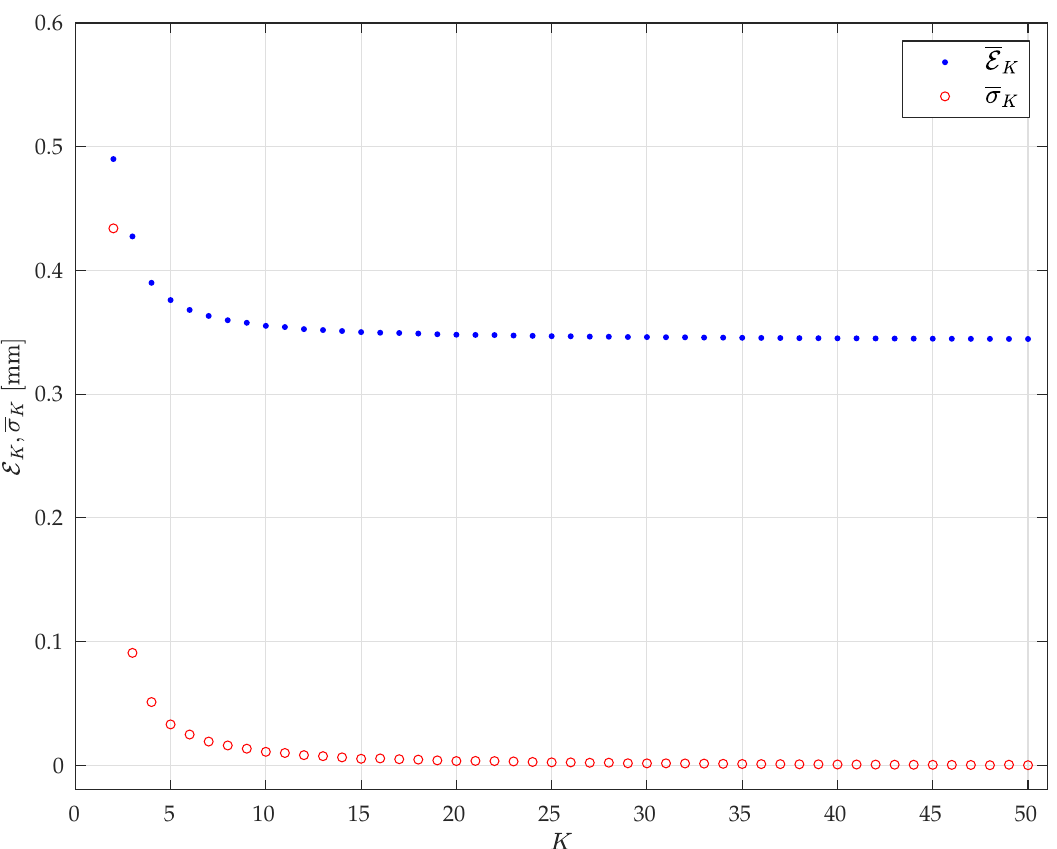
Figure 9. The R K -averaged point-to-point errors K = 2, . . . , N C .